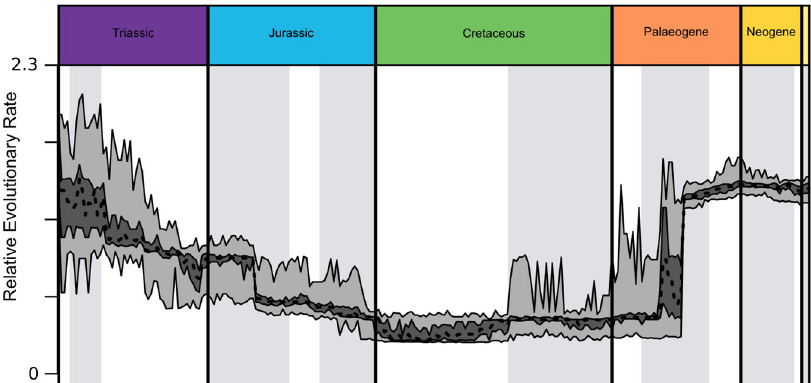
Fig. 2 Time-series representation of evolutionary rates. Rate values were output by a variable rate phylogenetic model implemented using BayesTraits. The taxa included in each 1-million-year interval are denoted using a phylogenetic tree, dated using using fi rst and last appearance dates. The taxa sampled in each 1-million-year interval were bootstrapped. Each bootstrap corresponded to a random 50% sample of the data in each bin, repeated 100 times. The interquartile range is shown in dark grey, the total range in light